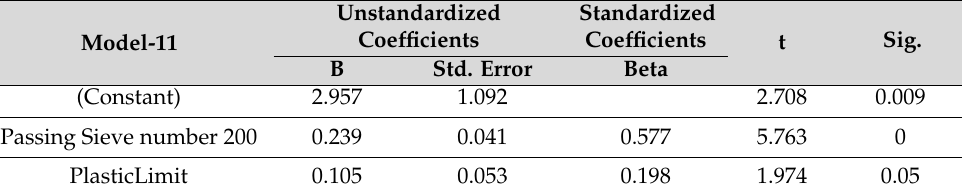
Table 10. OMC prediction